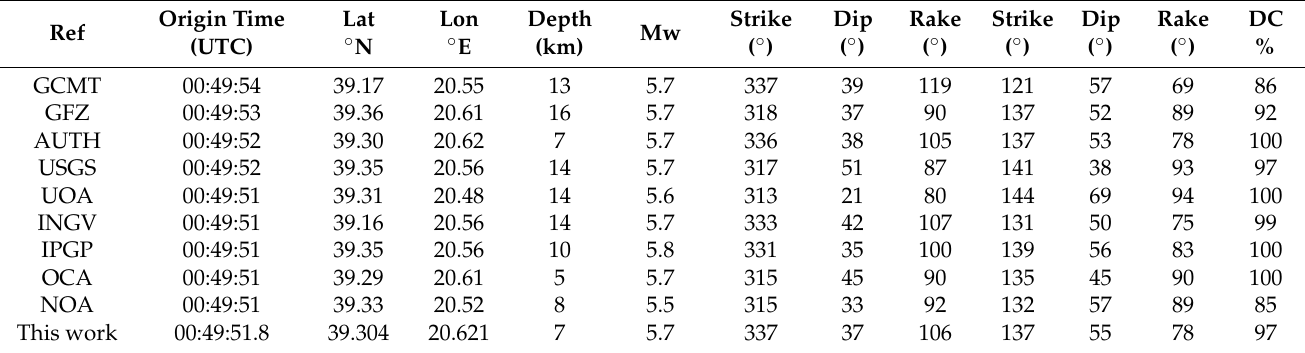
Table 2. Moment Tensor Solutions for the March 21, 2020, mainshock reported by different agencies and the solution calculated here. The GCMT scalar seismic moment = 4.78 · 10 17 N m. (GCMT- Global Centroid Moment Tensor;